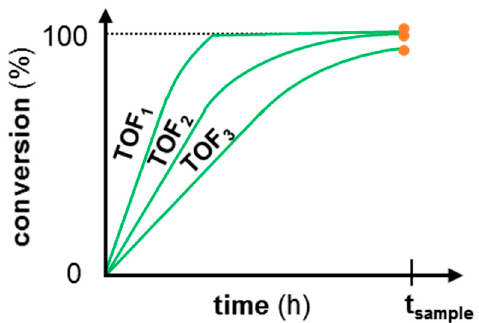
Figure 1. Hypothetical catalyst activity (turnover frequency—TOF) in a first and two recycle batch experiments for the reaction A → B. Only one sample is taken for each run after a time t sample , and is indicated in orange.